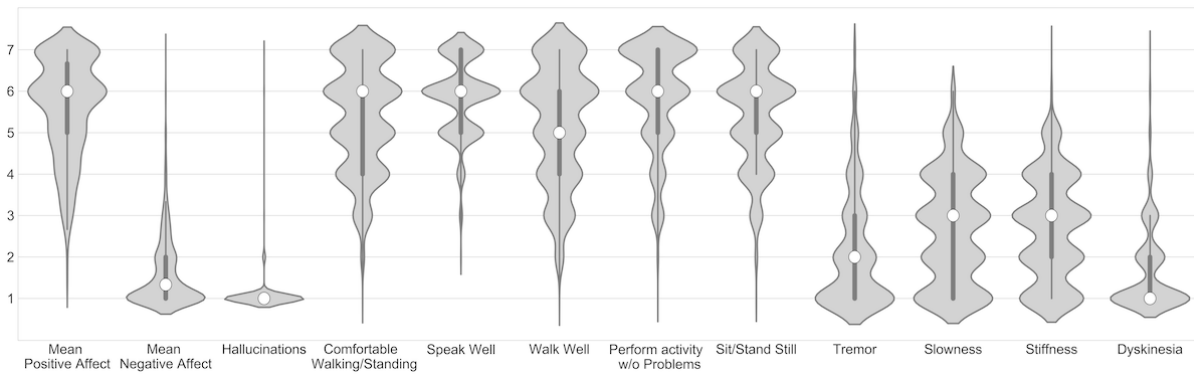
Figure 1. Distribution plots of answers from beep questionnaires. Mean positive and negative affect showed high and low mean answers, respectively. The ability to perform daily life tasks showed moderate-to-high mean answers, whereas the motor symptom items showed low-to-moderate mean answers. All items were statements and were answered on a 7-point Likert scale, ranging from 1 (not at all) to 7 (very). The white dot represents the median answer, the thick black line represents the IQR, and the thin black lines represent the rest of the distribution, calculated as IQR times 1.5. The width of the shapes correlates with the probability that the patient answered the corresponding